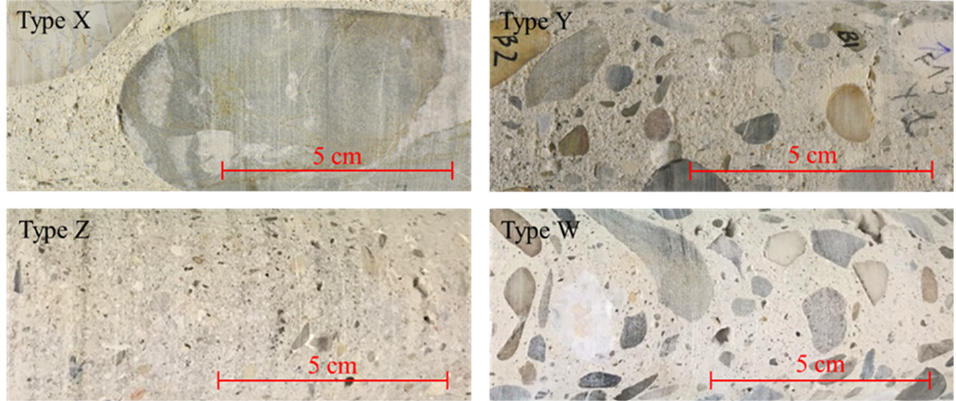
Figure 3. Macroscopic aspect of the four different macroscopic types of core samples. Table 1 summarizes the descriptions of each core, the position on riverbanks and the assigned macroscopic type. To carry out an initial assessment of the quality of the cores a standardized geotechnical method, the RQD index, was used [36] (Table 1). This index gives the qualitative and quantitative assessment of rock quality and degree of jointing and fracturing in a rock mass as the percentage of intact drill core pieces longer than 10 cm recovered. The quality classification based on the RQD index is divided into five classes: 0–25% (very poor quality), 25–50% (poor quality), 50–75% (fair quality), 75–90% good (quality), and 90–100% (very good quality). In this work, the RQD index has been applied considering that the extracted carrots are composed of aggregates of dimensions from about 1 cm to 10 cm. In addition, cohesion between the binder and such aggregates is considered. Table 1. Macroscopic descriptions of cores and RQD values. Cores